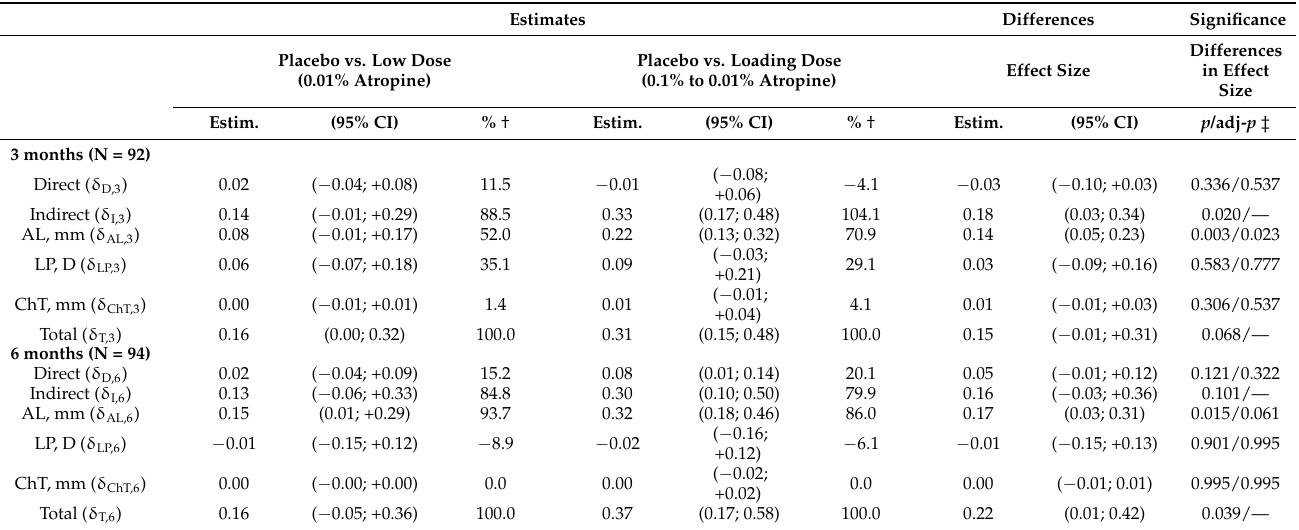
Table 3. Mediation